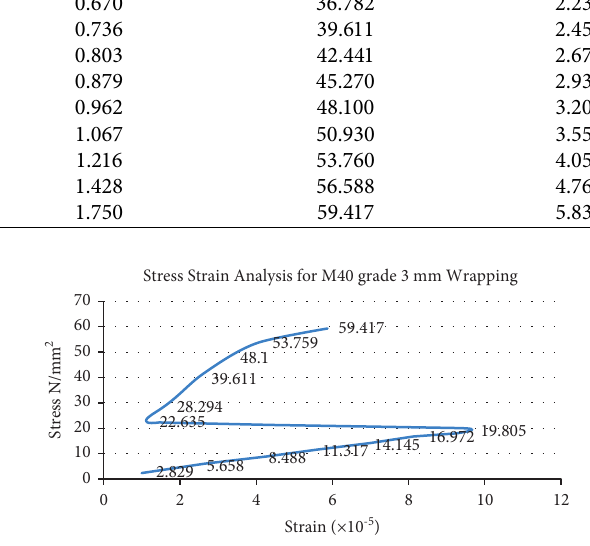
Figure 15: Stress-strain analysis for grade M40 with 3mm wrapping.